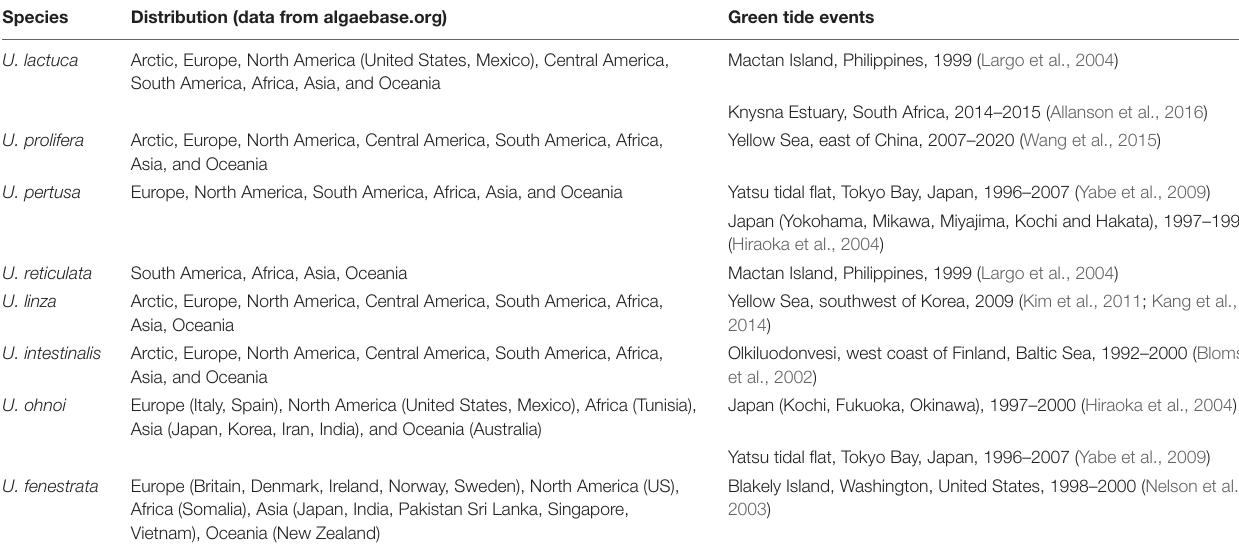
TABLE 1 | Major species of Ulva causing green tide. Species Distribution (data from algaebase.org) Green tide